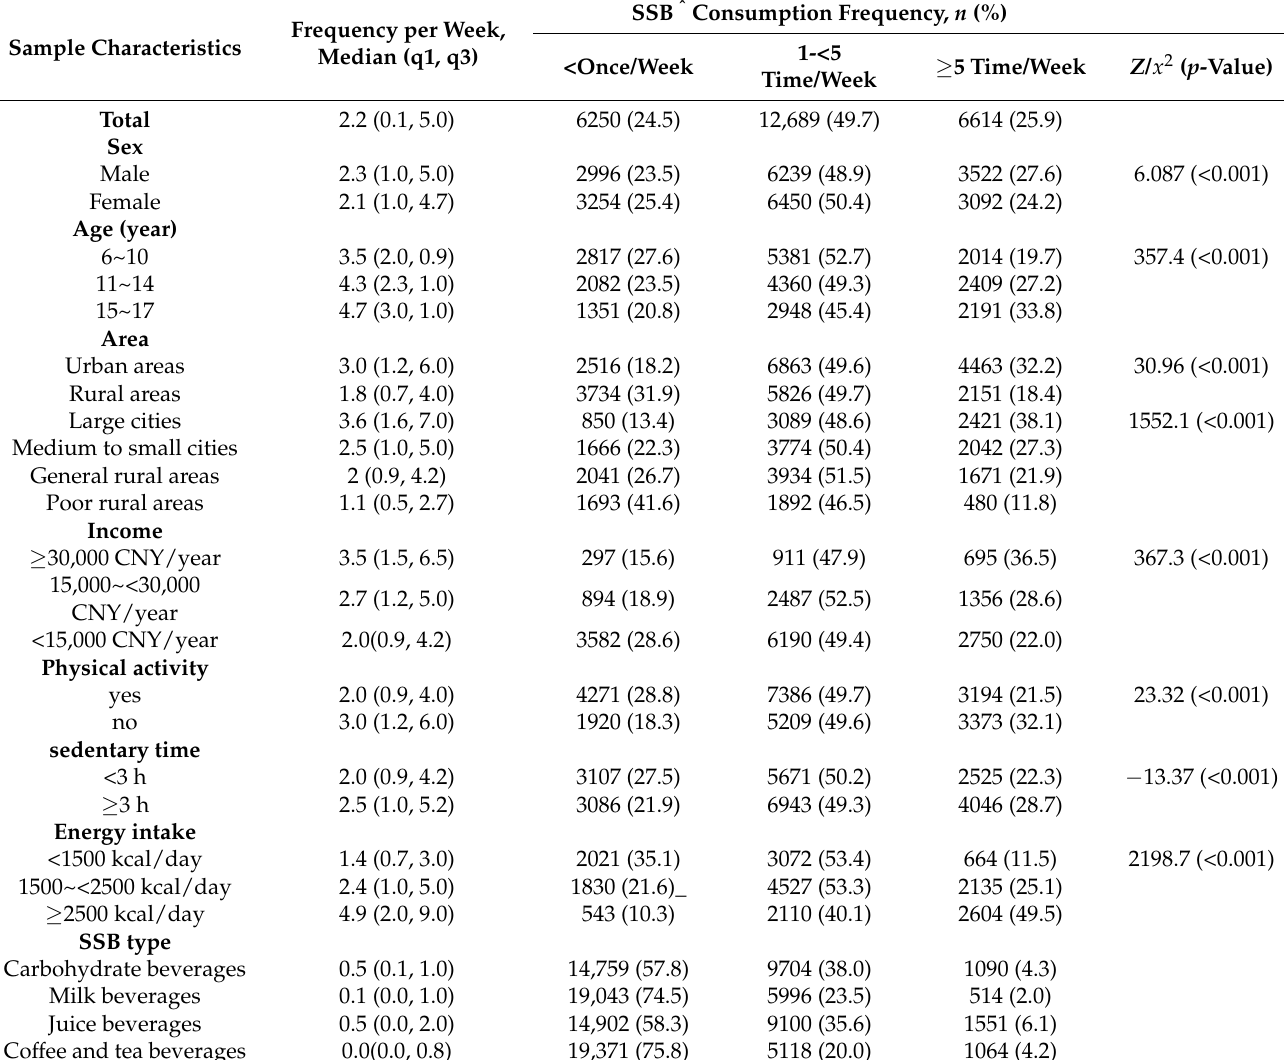
Table 2. Frequencies of SSB consumption among Chinese 6–17-year-old children in 2012 ( n =